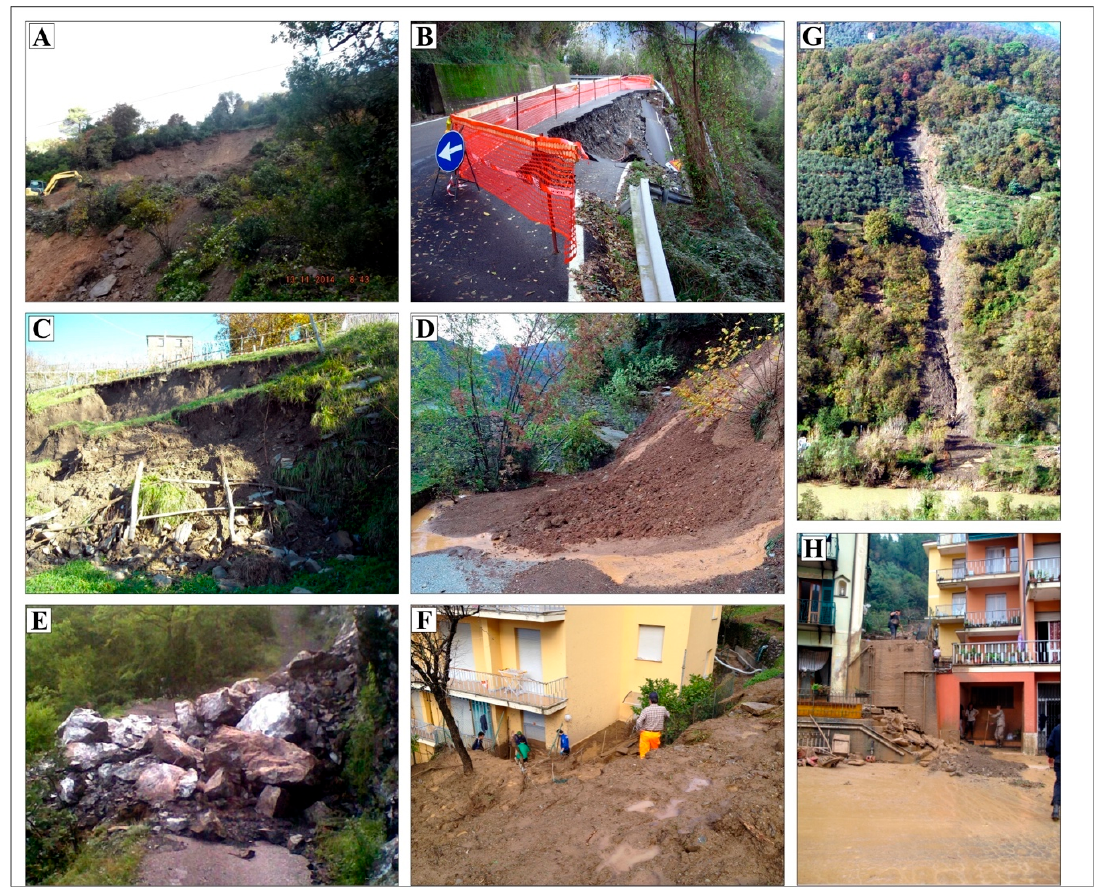
Figure 8. Examples of the different types of shallow landslides induced by rainfalls and the resulting damage: ( A ), roto-translational slide; ( B ), rotational slide downhill road cuttings, resulting in the partial collapse of the roadway; ( C ), shallow landslides on terraced slopes, with the collapse of the retaining walls; ( D ), complex movement uphill road cuttings, resulting in the roadway obstruction due to debris, blocks and vegetation; ( E ), rockfall; ( F , H ), soil slips and slow-moving earth flows, resulting in significant damage to buildings and man-made structures due to mud and debris; ( G ), rapid earth flow.